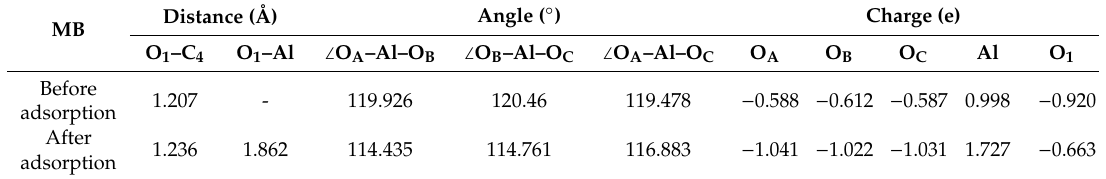
Figure 1. Adsorption structure of a methyl butyrate (MB) on the Lewis acid of ZSM-5 zeolite. Table 1. Geometry parameters and Mulliken charge of MB before and after adsorption.